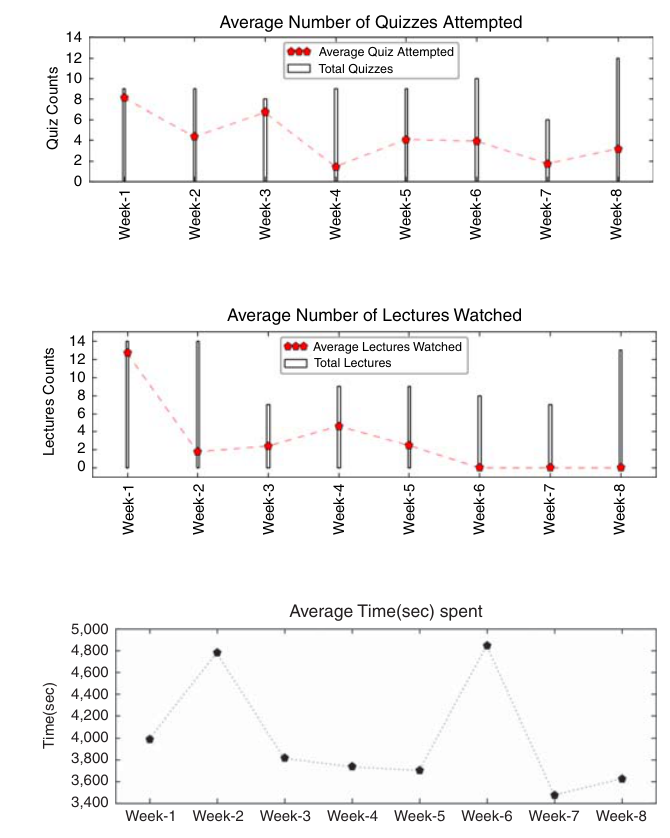
Figure 7. Average number of time (seconds) spent during the